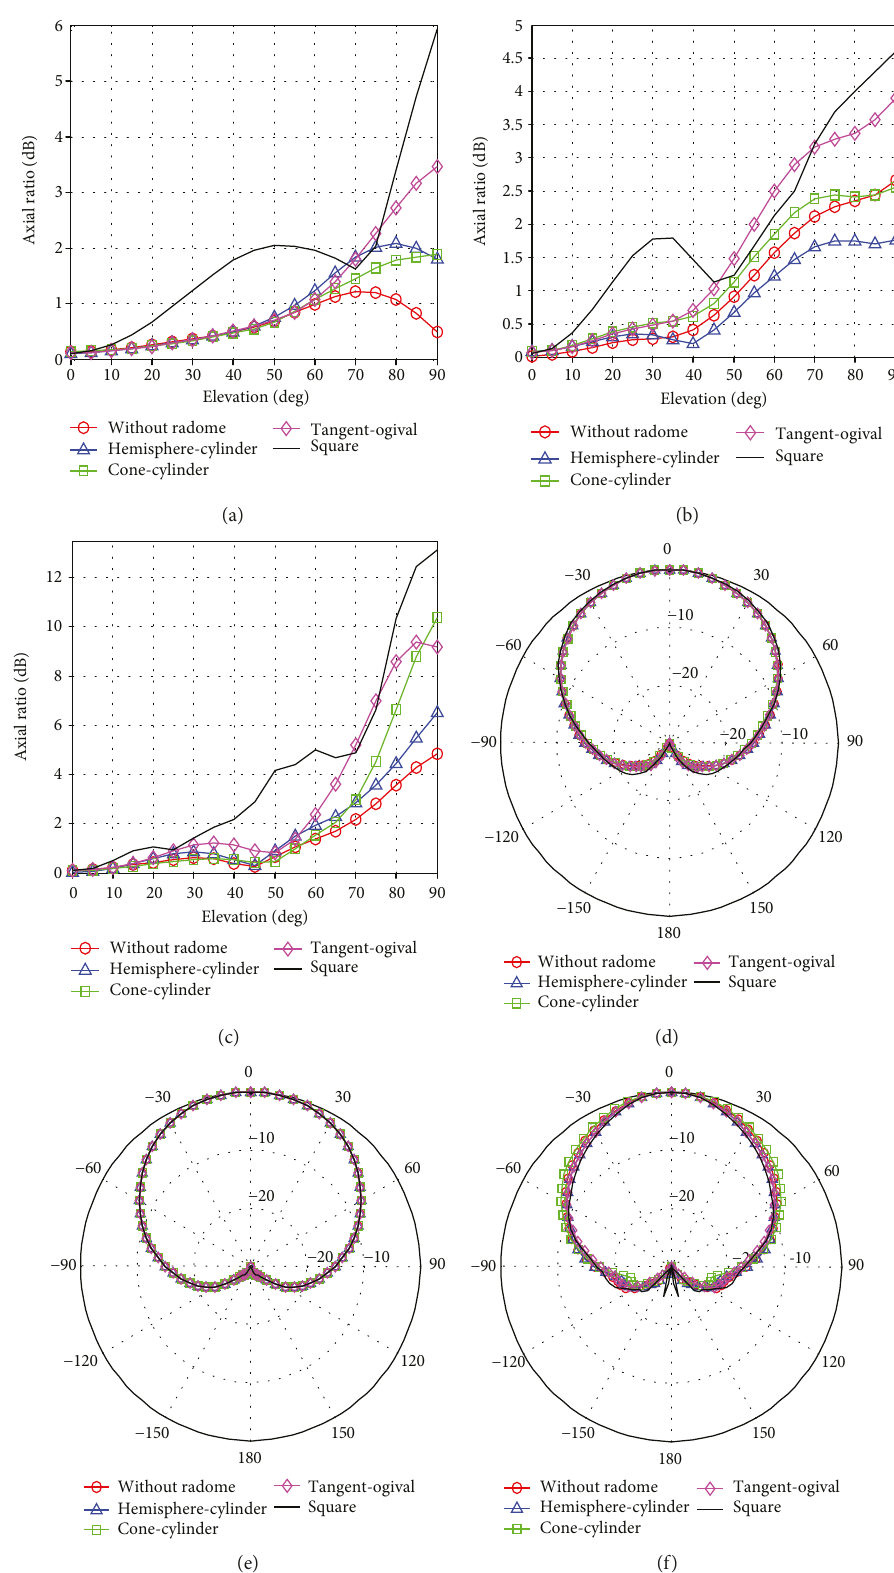
Figure 4: Simulated radiation characteristic comparison of antenna with di ff erent geometries of radomes: maximum axial ratio versus the elevation angle (a) at 1.22 GHz, (b) at 1.58GHz, and (c) at 2.5GHz; E-plane radiation pattern (co-pol) (d) at 1.22GHz, (e) at 1.58GHz, and (f) at